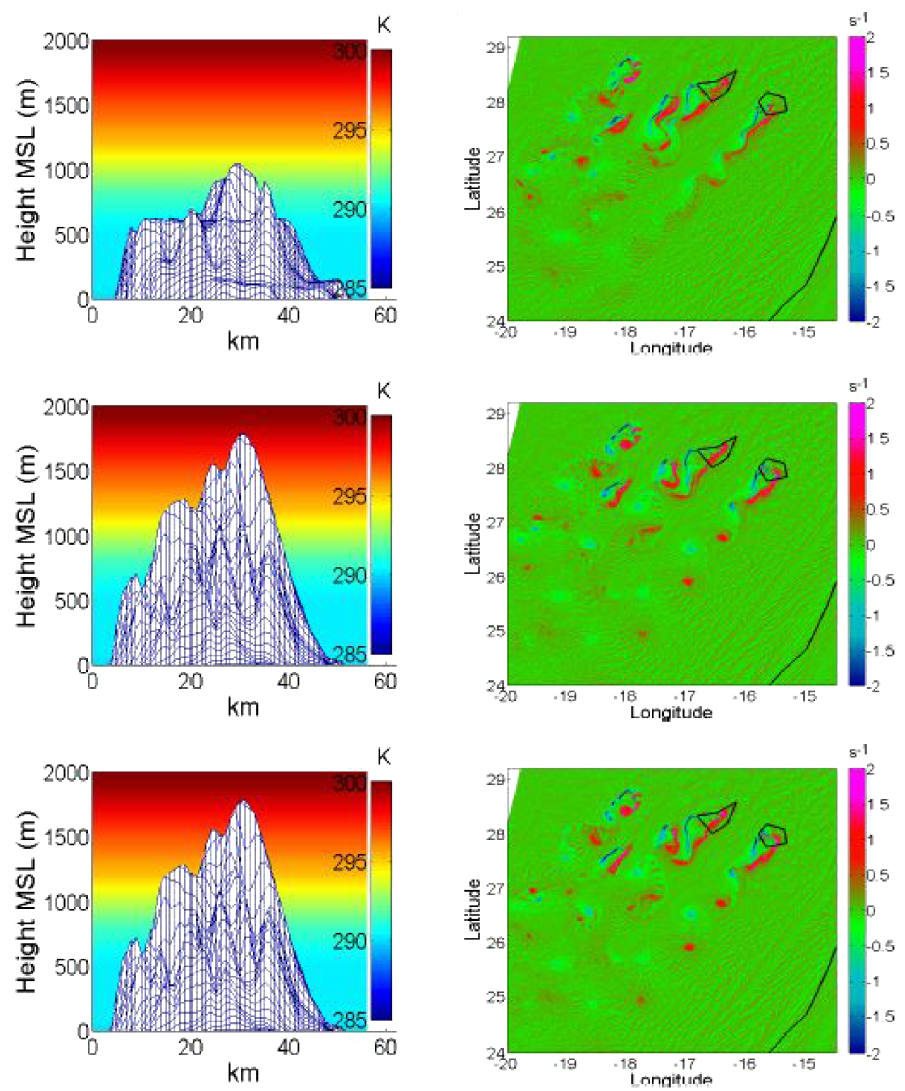
Figure 3. WRF model terrain height profiles of Gran Canaria as viewed from the south corresponding to GTOPO30 (upper left), SRTM30 (middle left), and GMTED30 (lower left). Background color scheme represents ambient upstream potential temperature profile. Upper right, middle right, and lower right panels depict instantaneous relative vertical vorticity averaged vertically across the lowest 15 grid levels for the GTOPO30-based, SRTM30-based, and GMTED30-based simulations, respectively. Table 2. Model physics